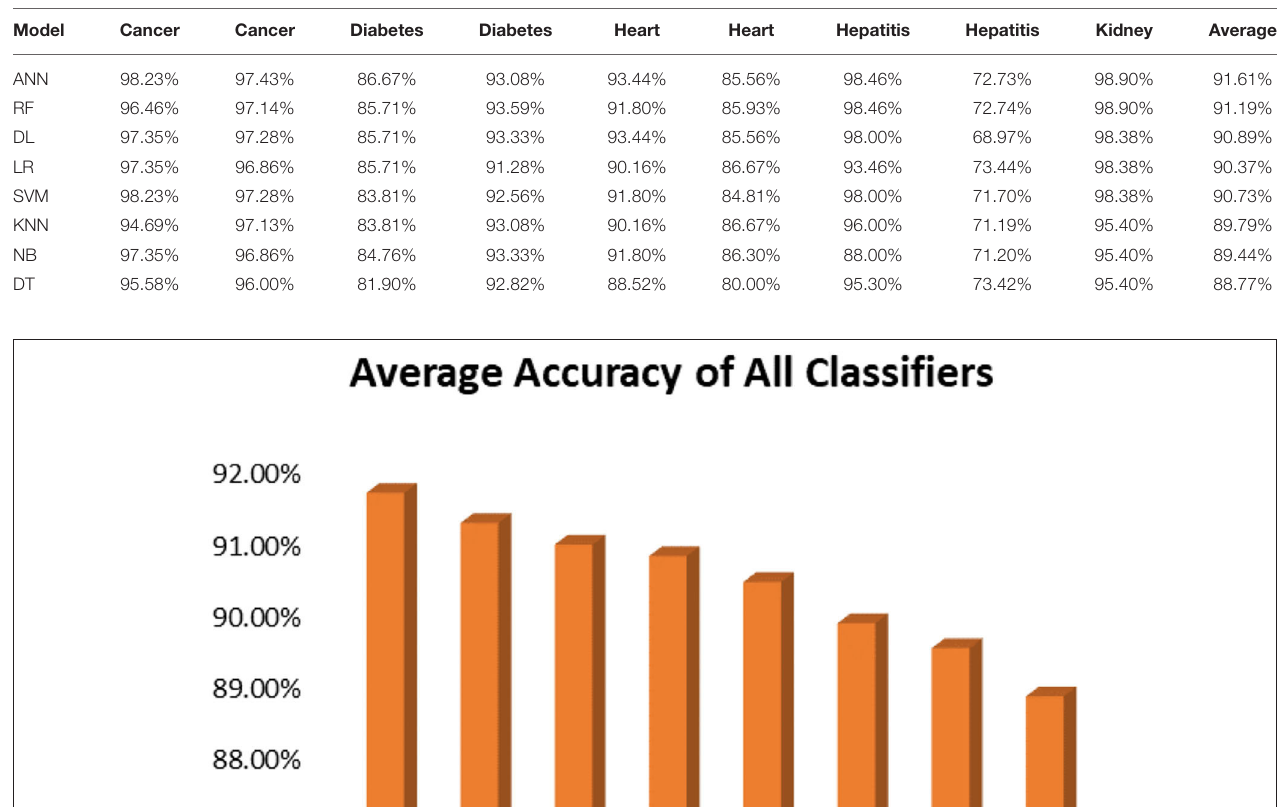
TABLE 4 | Overall accuracy achieved for all diseases prediction.